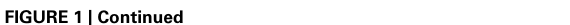
FIGURE 1 | Continued The ROBO/SLIT suite and the genes related to our initial gene set. The network was generated by String 9.1 with the proteins discussed in Section “The ROBO/SLIT Suite” plus the gene set related to globularity as advanced in Boeckx and Benítez-Burraco (2014).The medium confidence value was 0.0400. Nodes representing the proteins encompassing the network are colored randomly. In this confidence view, stronger associations between proteins are represented by thicker lines.The figure does not represent a fully connected graph, but readers are asked to bear in mind that String 9.1 predicts associations between proteins that derive from a limited set of databases.The material discussed in the main text lead us to suspect connections that String does not generate (although we wish to note that just adding a few genes, not discussed in this paper, yield a connected graph). It should be emphasized that the nature of String 9.1 is essentially predictive, and not explanatory. Although we have confirmed all the links we discuss here in the literature, they need to be confirmed at the brain level and in relation to language. Additionally, the diagram only represents the potential connectivity between the involved proteins, but this has to be mapped onto particular biochemical networks, signaling pathways, cellular properties, aspects of neuronal function, or cell-types of interest that can be confidently related to aspects of language development and